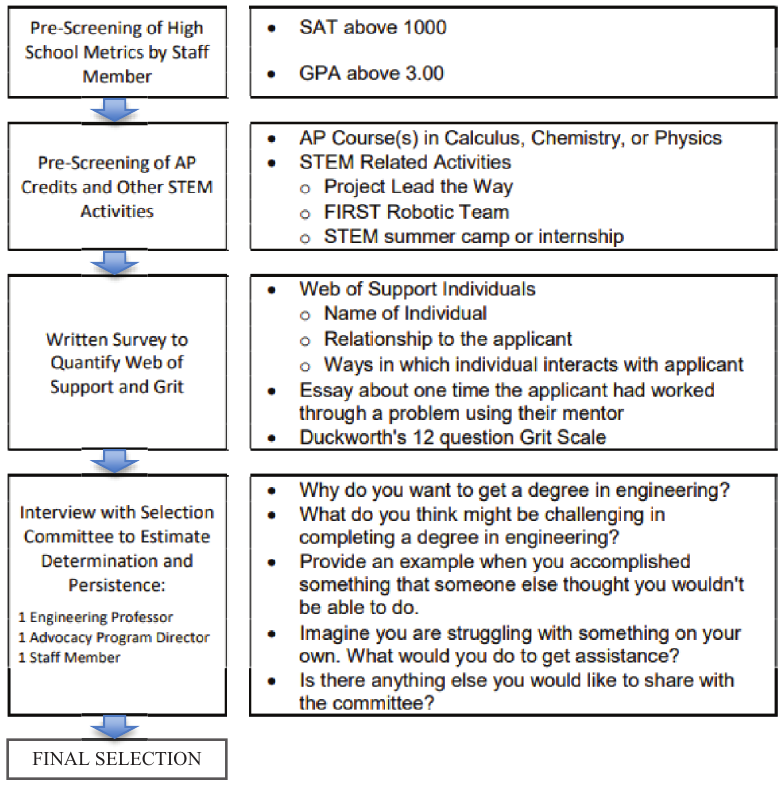
Fig. 5. Purdue Rising Scholar recruitment pathway for matriculation into the NSF S-STEM